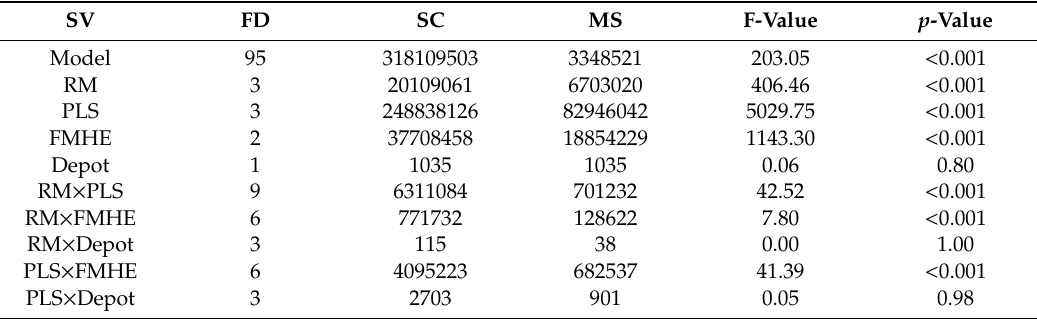
Table 4. ANOVA of full factorial design for the